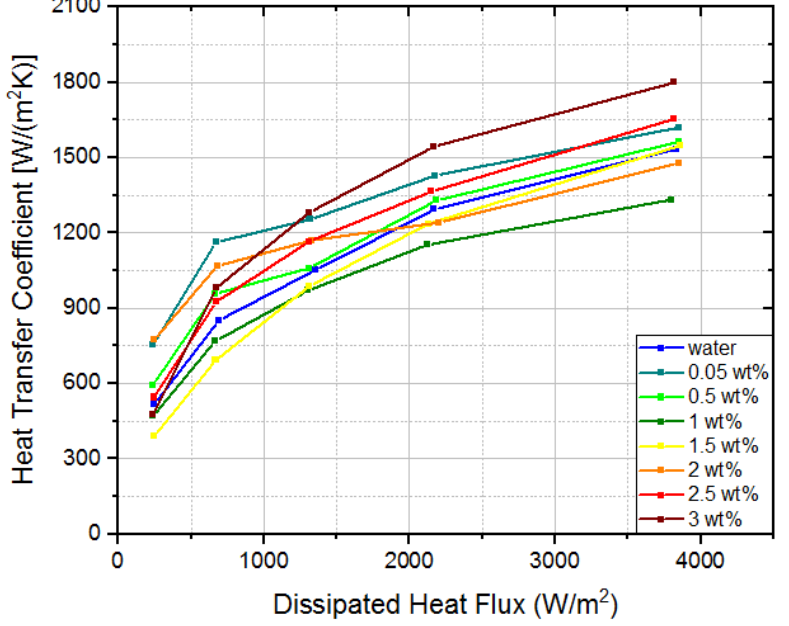
Figure 7. Dissipated heat flux versus heat transfer coefficient. The superhydrophobic region is 1.5 mm in diameter.